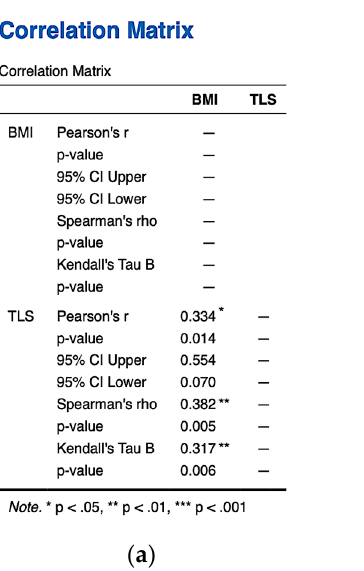
Figure 2. Correlation matrix showing the interrelation between BMI and TLS stromal blood vessels in BC tissues ( p = 0.014 was significant). BMI significantly influenced the TLS presence ( a ) while TLSs are highly correlated with both immature (IBV_CD34+/SMA − , p = 0.008) and mature tumor (MBV_CD34+/SMA+, p = 0.003) stroma blood vessels ( b